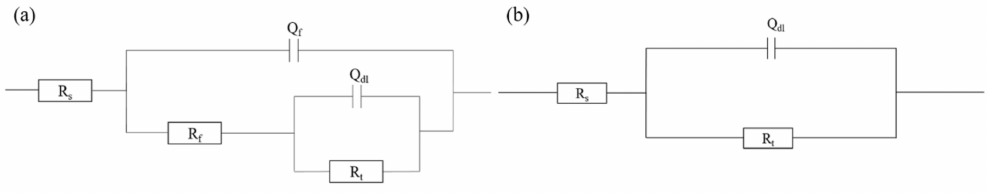
Figure 16. Equivalent circuit for fitting ( a ) DFS / WRS and ( b )